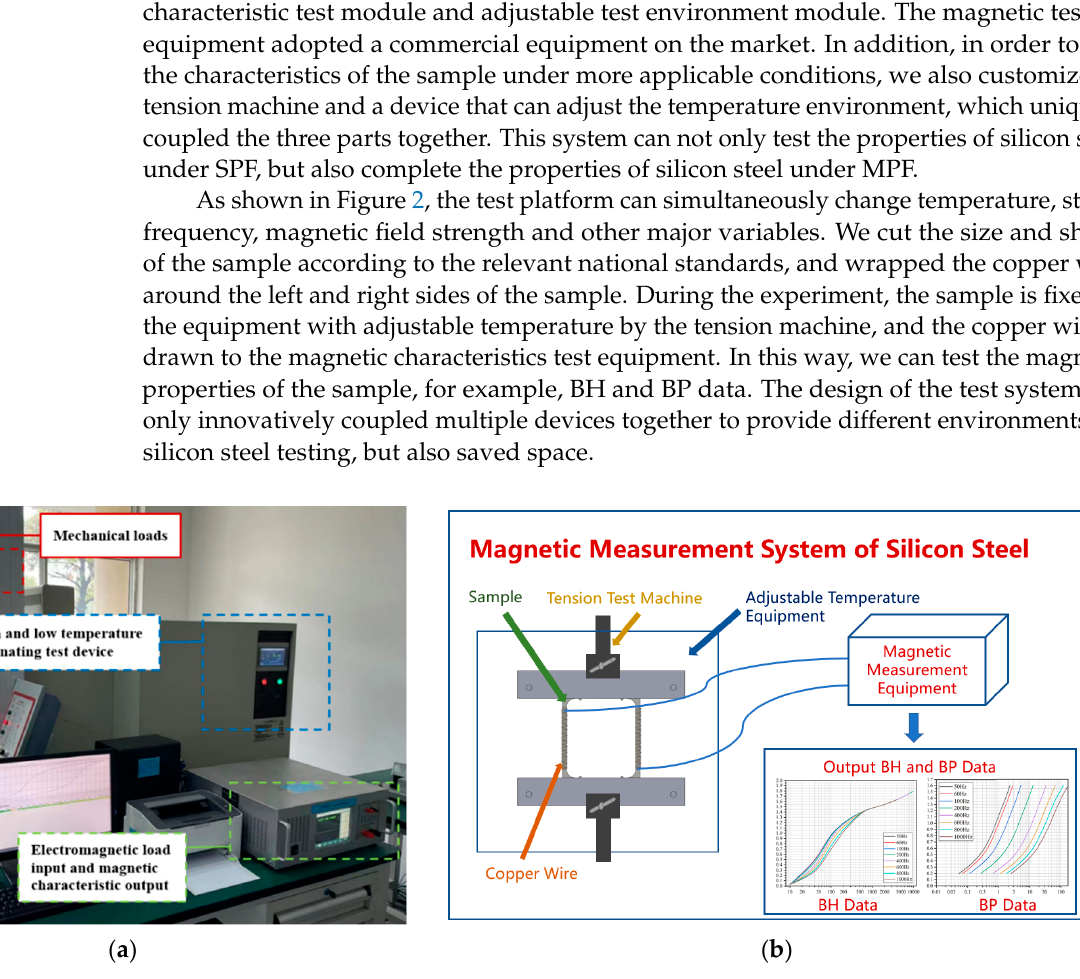
Figure 2. Test platform. ( a ) Actual test system; ( b ) schematic diagram.